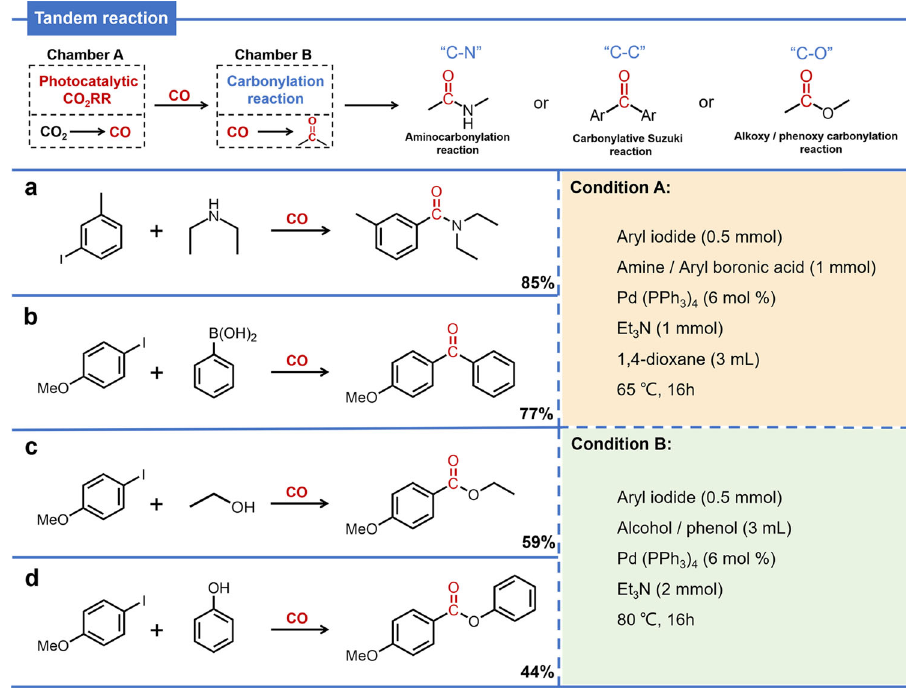
Fig. 8 Expanding different carbonylation reactions to our tandem reaction. a Aminocarbonylation reaction using tandem catalysis system. b Carbonylative Suzuki coupling reactions using tandem catalysis system. c , d Phenoxycarbonylation/alkoxycarbonylation reaction using tandem catalysis